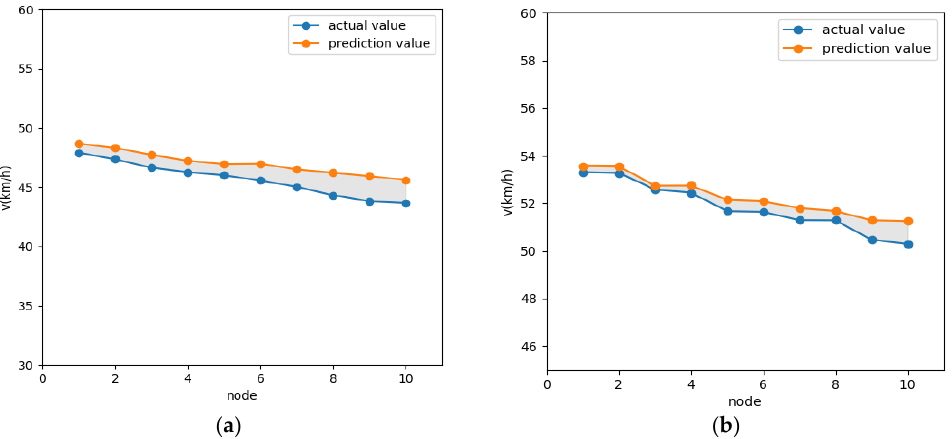
Figure 10. Real speed vs. predicted speed: ( a ) 3 s real speed vs. predicted speed; ( b ) 3 s real speed vs. predicted speed.